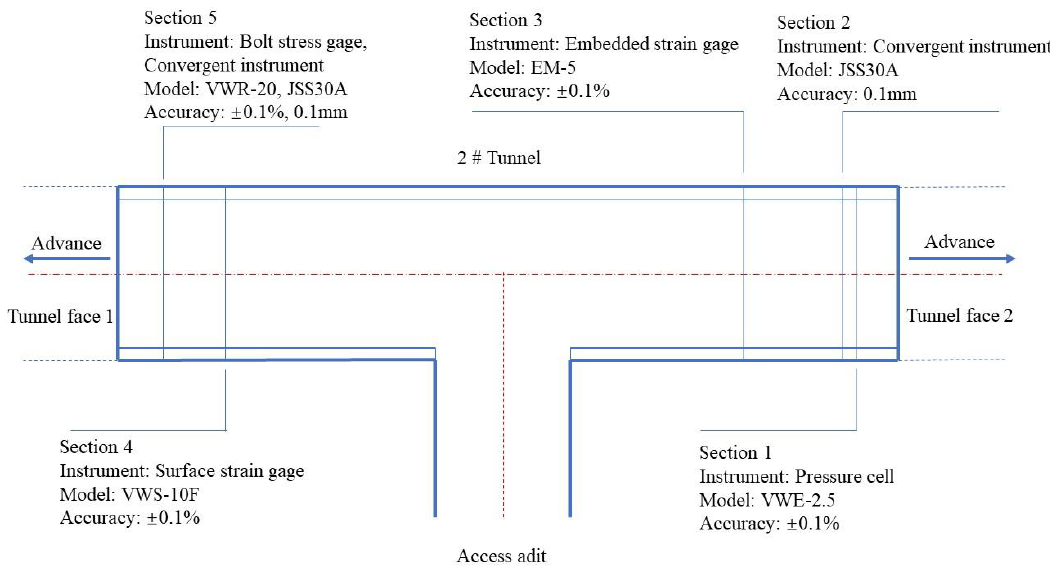
Figure 7. The distribution position of monitoring section in the tunnel.